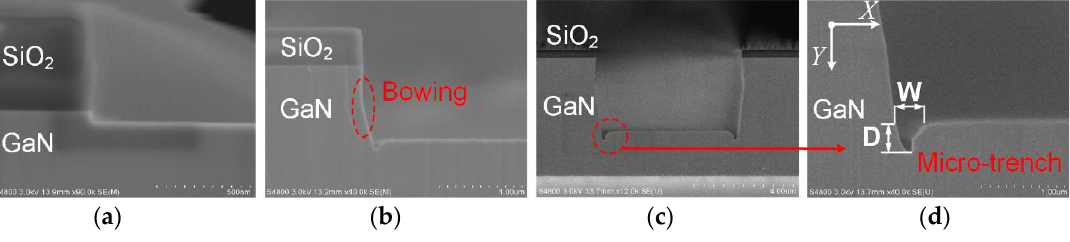
Figure 6. ( a – c ) SEM images of sidewall profiles of SiO 2 -masked GaN with di ff erent etch times: ( a ) 30 s; ( b ) 7 min; ( c ) 20 min. The marked corner was chosen to show the details of the microtrench. ( d ) SEM image of the microtrench at the bottom corner of the mesa. D and W are the depth and width of the microtrench, respectively.